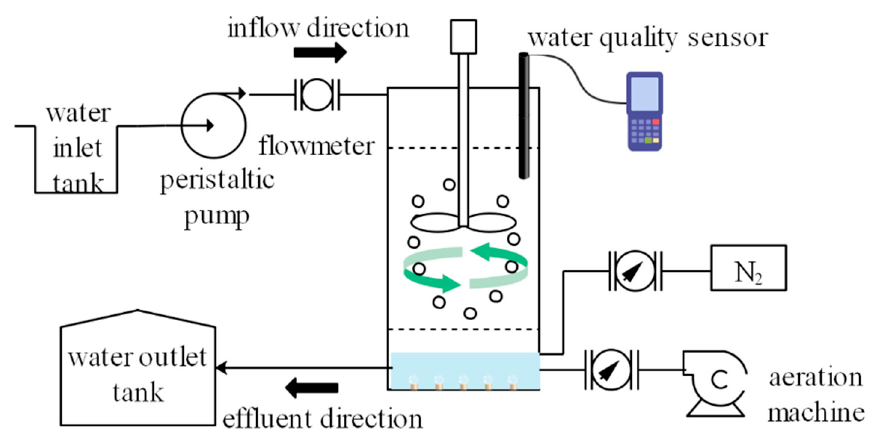
Figure 1. Schematic diagram of the experimental facility.